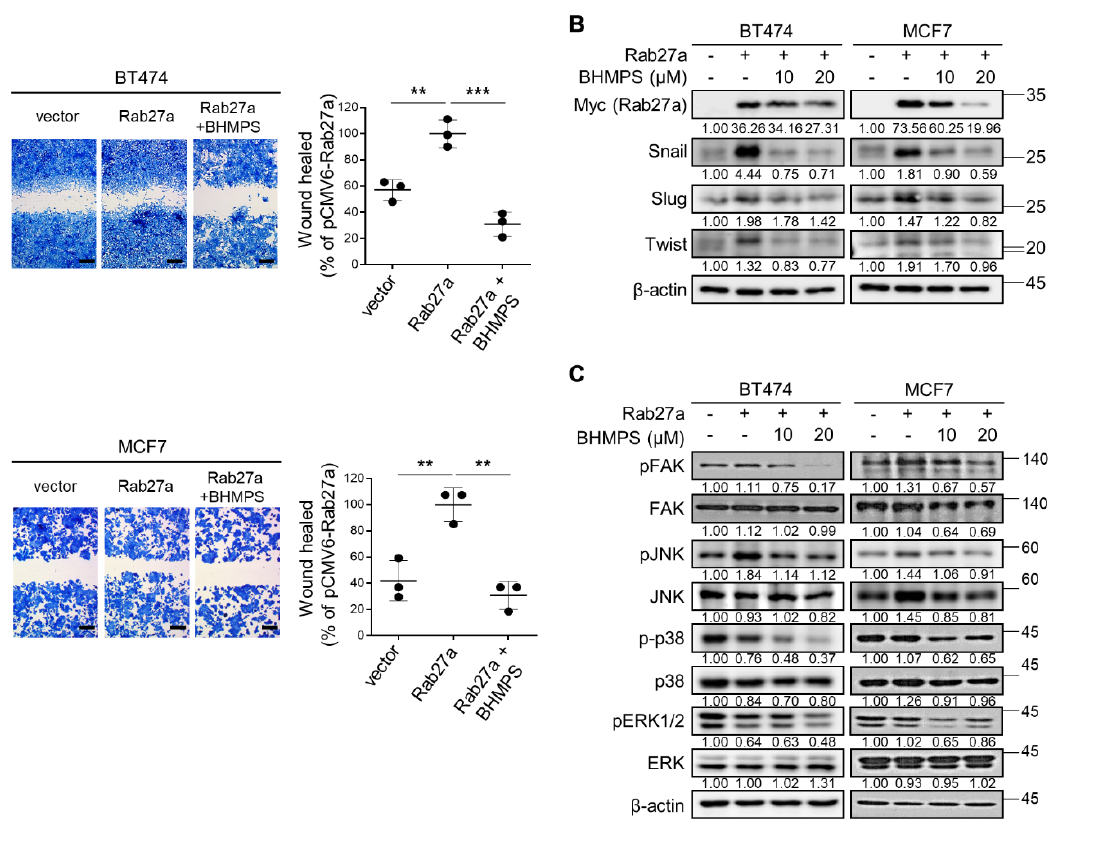
Figure 3. Rab27a overexpression promotes breast cancer cell migration. ( A ) BT474 and MCF7 cells were transfected with control or Rab27a expression vector. After 24 h, the cells were treated with 10 µM of BHMPS, and the percentage of migrated cells was determined. Statistically significant differ- ences are shown in comparison with the Rab27a overexpression group. Representative images (40× magnification, Scale bars 250 µm) and means ± SD are from three independent experiments. ** p < 0.01 and *** p < 0.001 compared with Rab27a overexpression control. ( B ) BT474 and MCF7 cells were transfected with Rab27a-Myc-DDK expression vector. After 24 h, the cells were treated with the indicated concentrations of BHMPS for 24 h. The immunoblots show the expression of EMT-acti- vating transcription factors. ( C ) Under the same experimental conditions as ( B ), FAK and MAPK signaling was determined by western blotting. ( D , E ) After 24 h of Rab27a overexpression, cells were treated with the indicated concentrations of JNK inhibitor (SP600125) or FAK inhibitor (PF573228) for 4 h. The uncropped images are shown in Supplementary Materials.